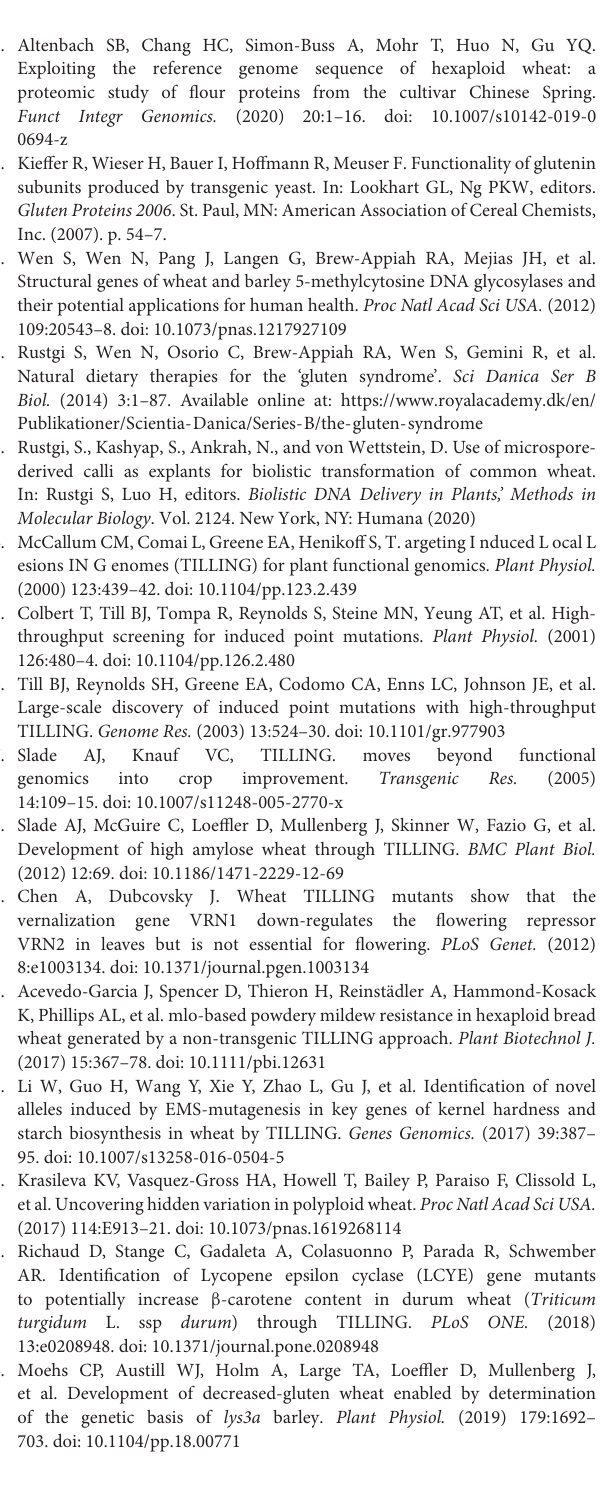
the homozygous mutants to be checked for their transcriptional and protein profiles [modified from (22)]. Supplementary Table S3 | List of wheat DEMETER mutants and their gluten